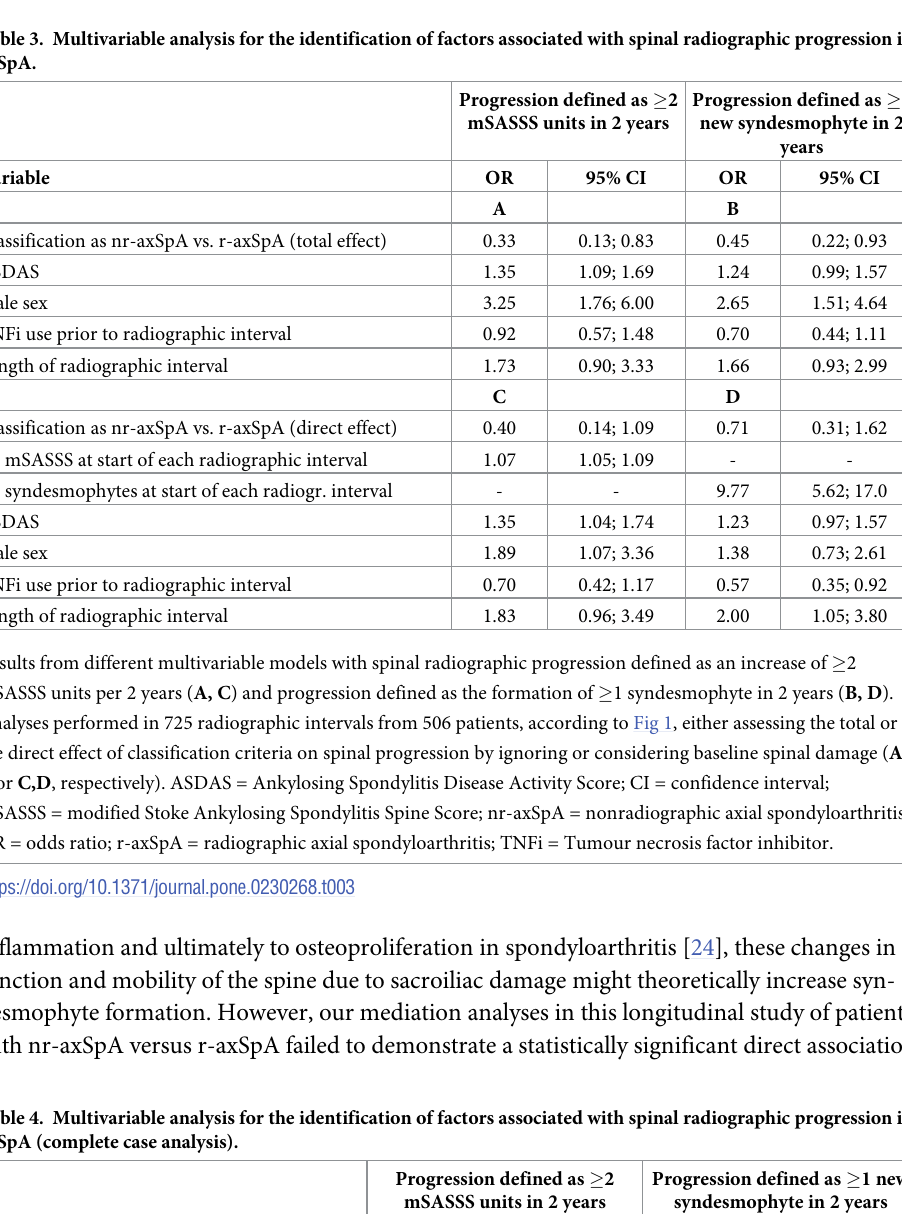
Table 4. Multivariable analysis for the identification of factors associated with spinal radiographic progression in axSpA (complete case analysis). Progression defined as � 2 Progression defined as � 1 new mSASSS units in 2 years syndesmophyte in 2 years Variable OR 95% CI OR 95% CI A B Classification as nr-axSpA vs. r-axSpA 0.20 0.06; 0.68 0.31 0.12; 0.80 ASDAS 1.39 1.10; 1.76 1.26 0.99; 1.61 Male sex 3.24 1.60; 6.55 3.00 1.53; 5.87 TNFi use prior to radiographic interval 1.02 0.61; 1.70 0.85 0.51; 1.41 Length of radiographic interval 1.57 0.75; 3.26 1.55 0.80; 3.01 Analysis performed in 602 radiographic intervals from 427 patients. ASDAS = Ankylosing Spondylitis Disease Activity Score; BMI = Body Mass Index; CI = confidence interval; mSASSS = modified Stoke Ankylosing Spondylitis Spine Score; nr-axSpA = nonradiographic axial spondyloarthritis; OR = odds ratio; r-axSpA = radiographic axial spondyloarthritis; TNFi = Tumour necrosis factor inhibitor.